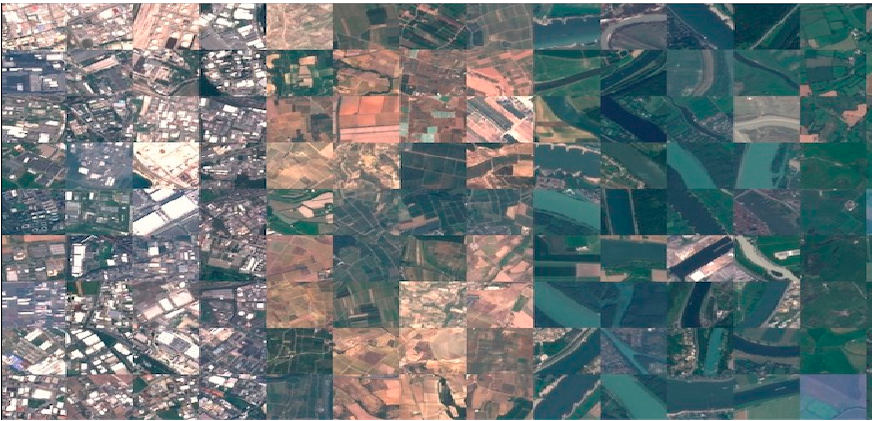
Figure 3. Sample image of Eurosat dataset [26].